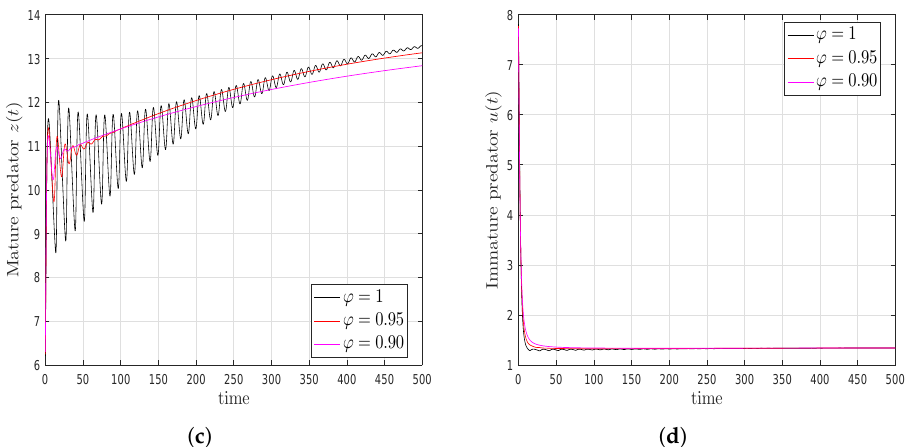
Figure 9. Time series graphical representations for food web mathematical System (13) with general- ized Caputo fractional operator when ρ = 0.80.